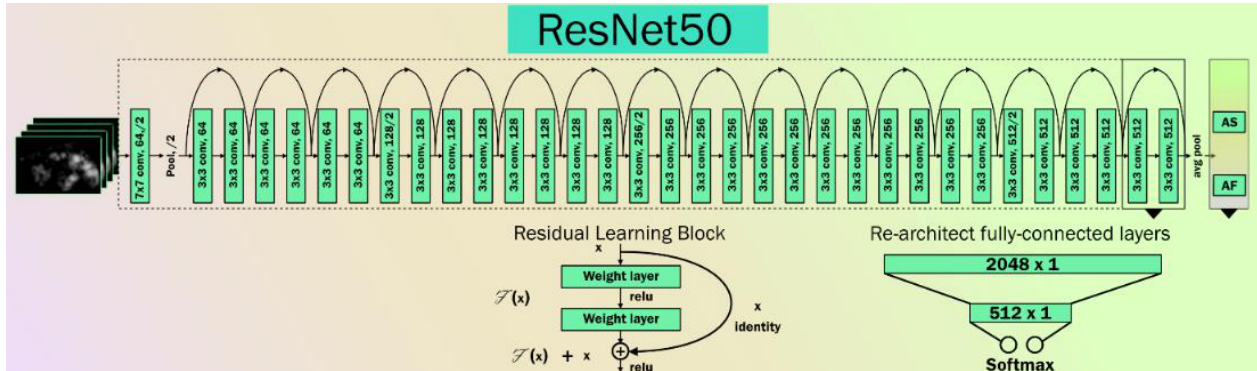
Figure 6. ResNet Architecture.